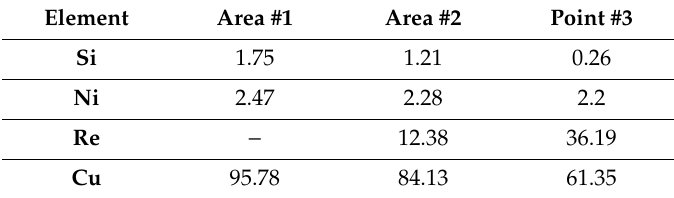
Table 5. Results of the EDS spectrum analysis for the areas from Figure 9 (wt.%).